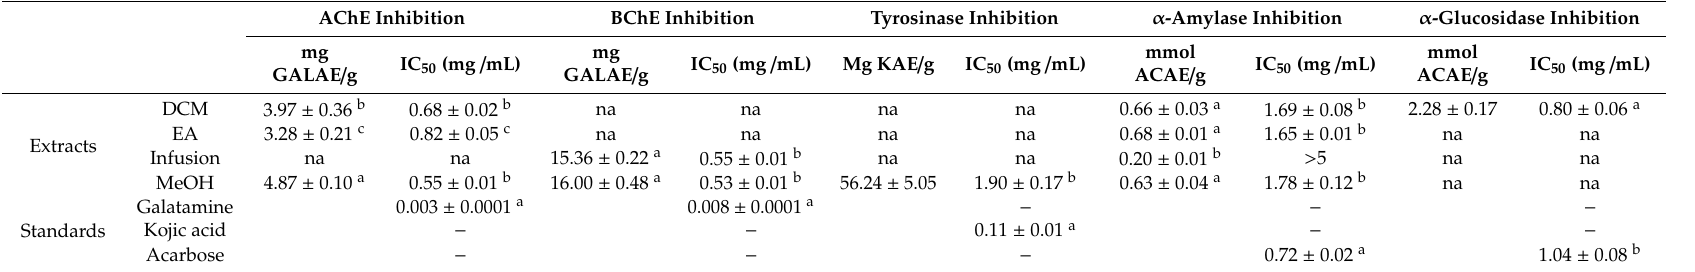
Table 2. Enzyme inhibitory properties of the tested extracts